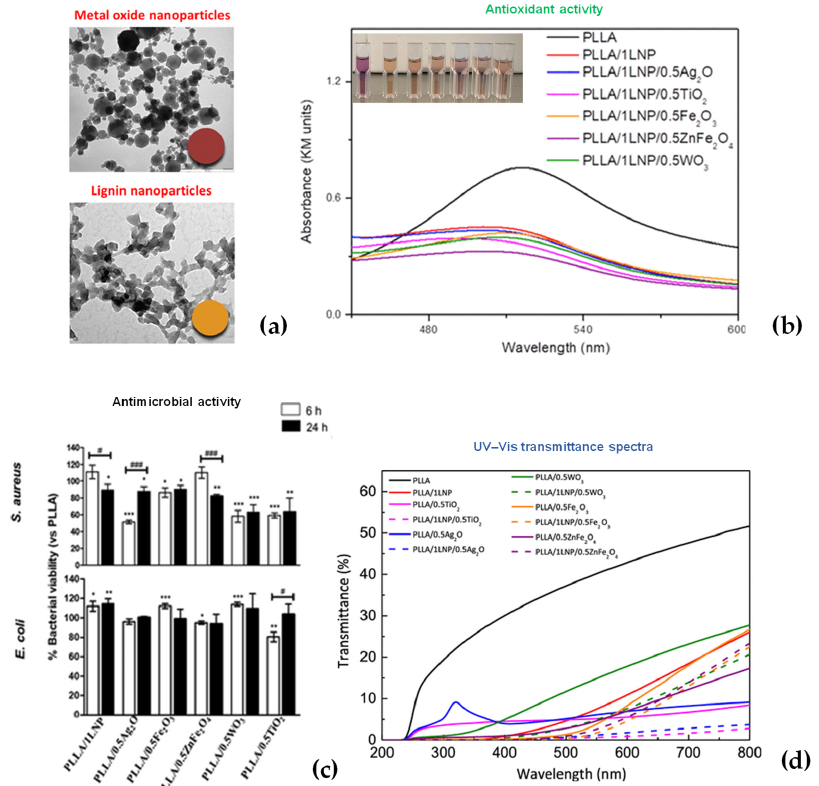
Figure 7. ( a ) TEM images of metal oxide (Fe 2 O 3 ) and lignin nanoparticles (LNPs); ( b ) antioxidant activities of PLLA-based systems, antimicrobial activities; ( c ) antimicrobial activities of PLLA binary systems; ( d ) UV–vis spectra of PLLA binary and ternary films. Reprinted from [49]. Copyright 2020 American Chemical Society.